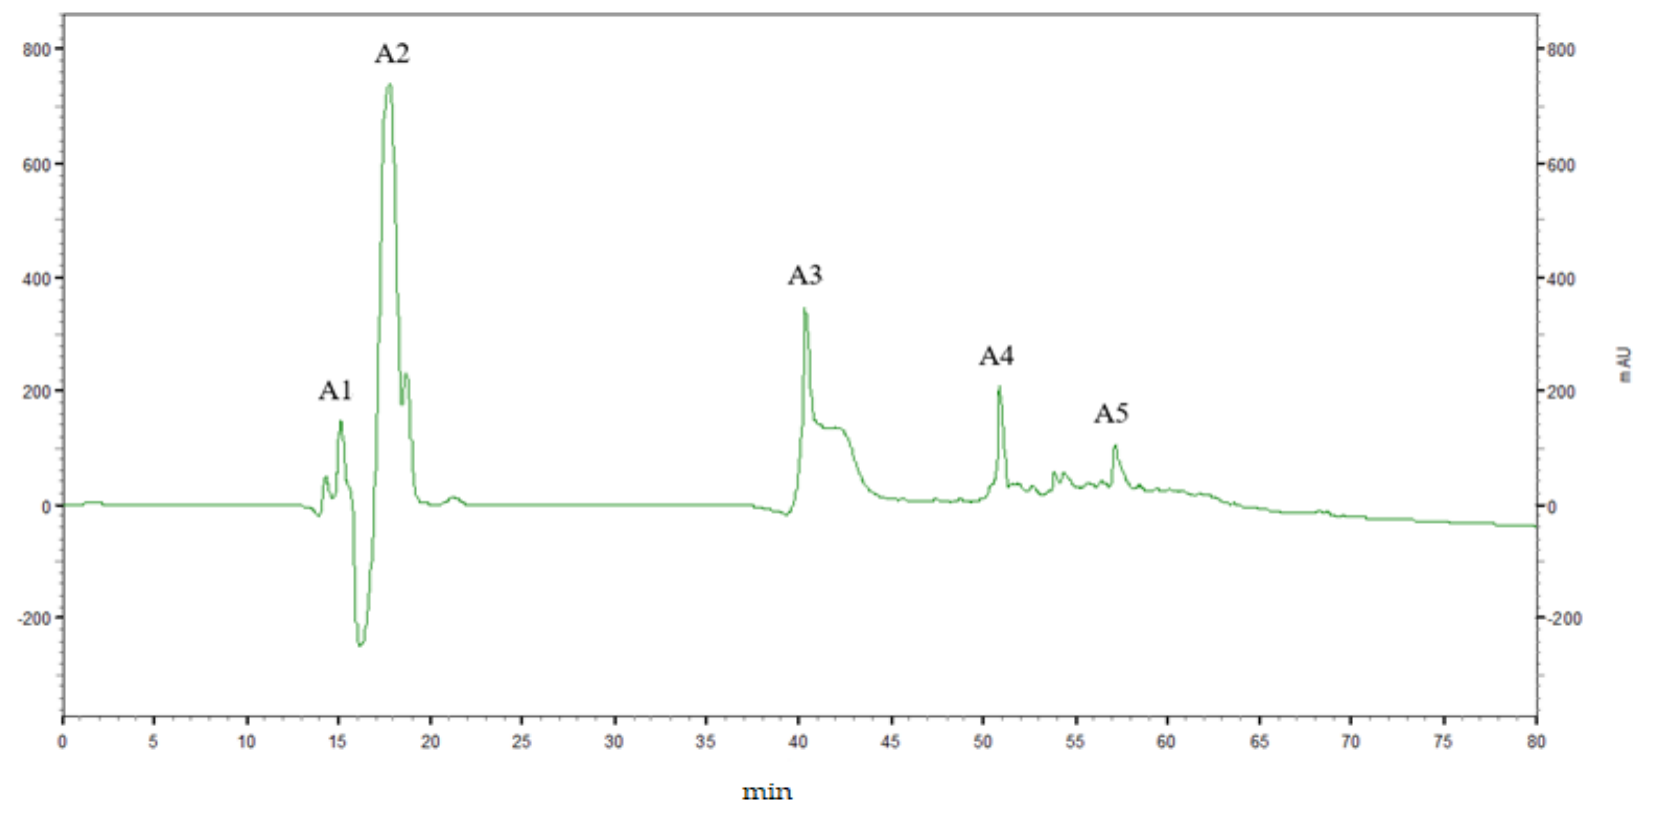
Figure 4. Elution profile of GTN4H-A by C18 reversed-phase HPLC. (Flow rate of 1 mL/min with a 0–80% linear gradient of acetonitrile in distilled water containing 0.1% TFA).